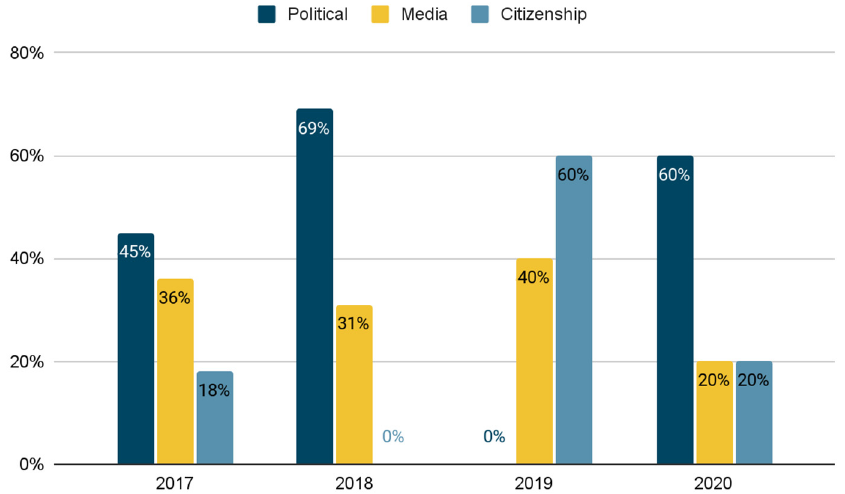
Figure 5. Percentages of the types of institutions that the sample of Spanish deputies started to follow in 2017, 2018, 2019 and 2020.